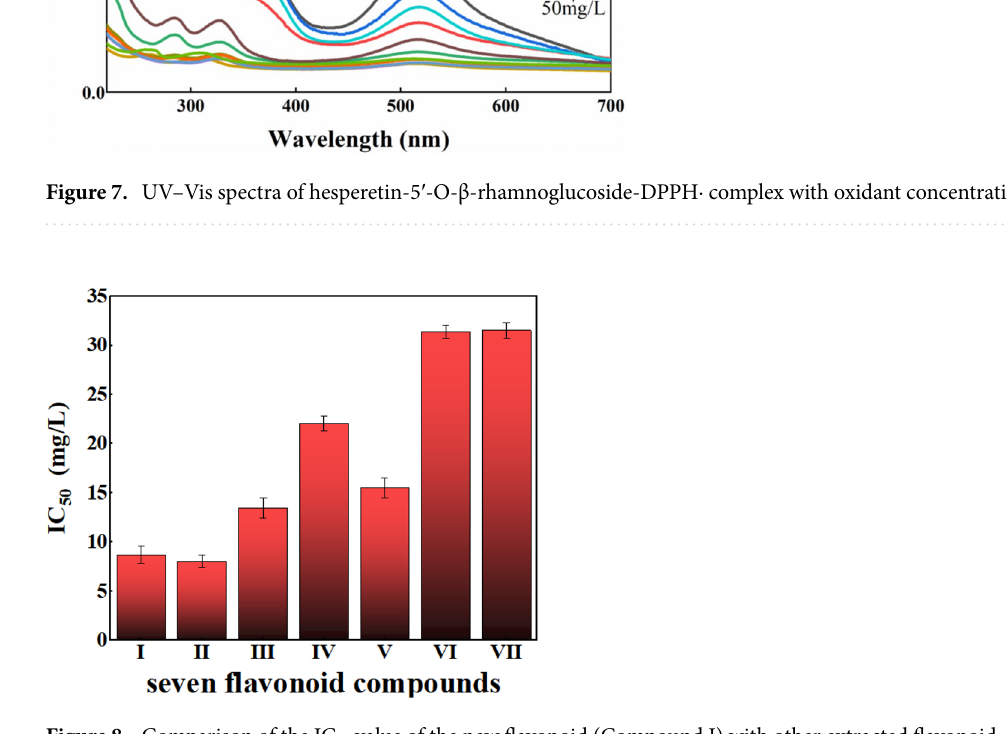
Figure 8. Comparison of the IC 50 value of the new flavonoid (Compound I) with other extracted flavonoid compounds. All the measurements were made in triplicate, and the IC 50 values are shown as the mean ± standard deviation in the